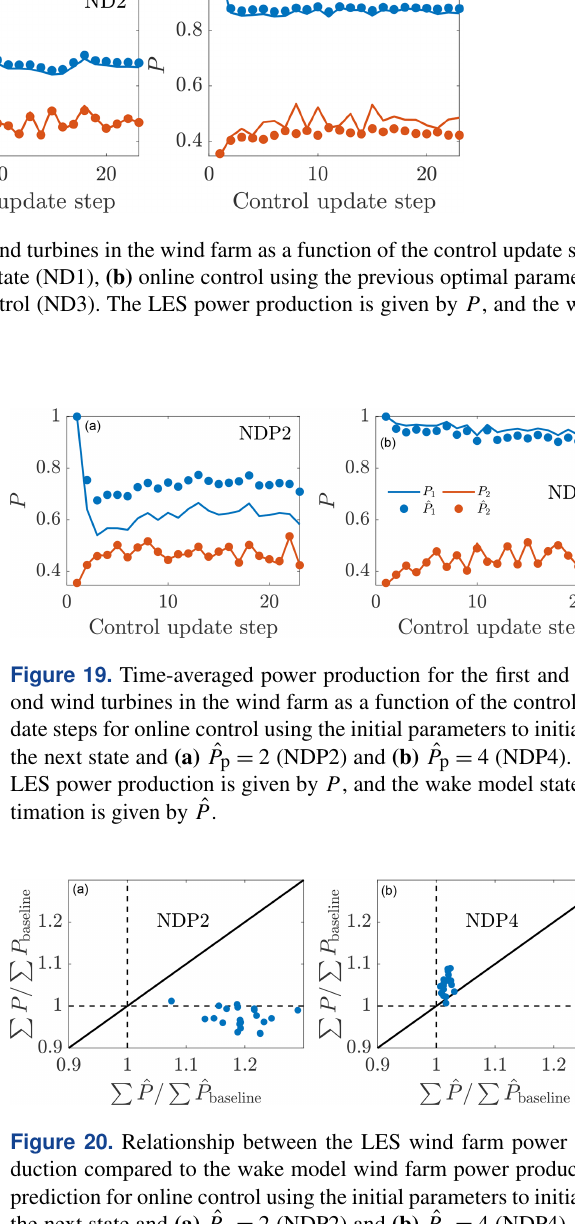
dictions were 0 . 044, 0 . 015, and 0 . 018, given as a fraction of P 1 , baseline , for ˆ P p = 2, 3, and 4, respectively. The mean ab- solute errors as a function of the control update steps for the three simulations are shown in Fig. 22. The averages over the control update steps of the mean absolute errors for the three cases are 0 . 05, 0 . 029, and 0 . 036 for ˆ P p = 2, 3, and 4, respec- tively. Qualitatively, ˆ P p = 3 and 4 result in predictions which are accurate and within 1 standard deviation of the